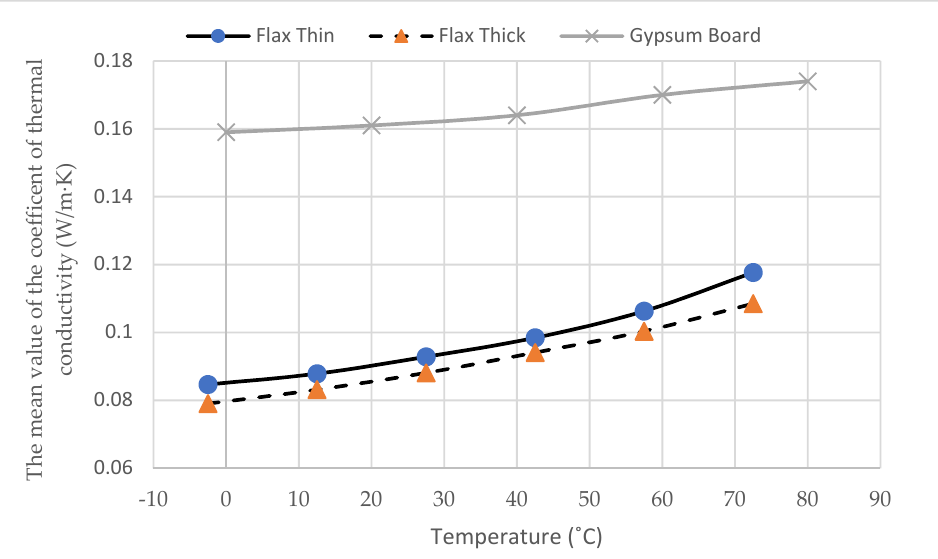
Figure 9. Thermal conductivity of kraft-paper honeycomb sandwich panels compared to gypsum board.